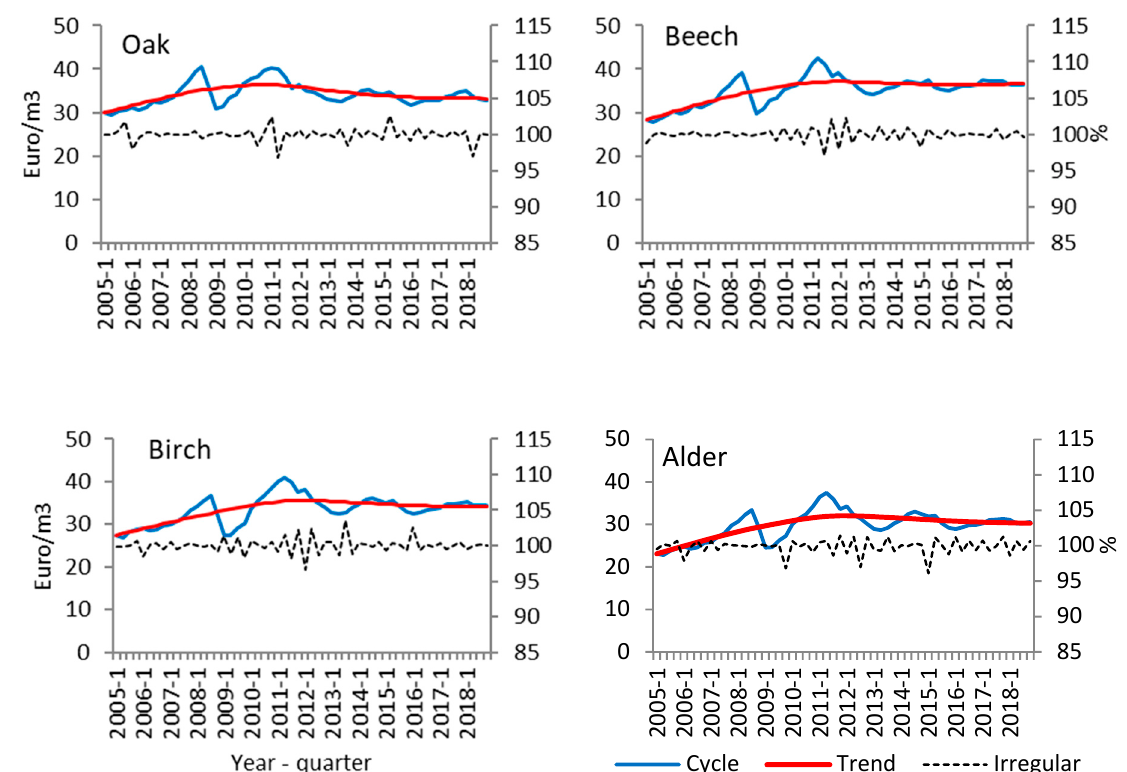
Figure 3. Irregular and cyclical fluctuations and long term trends in the prices of medium-diameter timber in Poland in 2005–2018; left axis—cyclical fluctuations and long-term trends, right trend—irregular fluctuations.